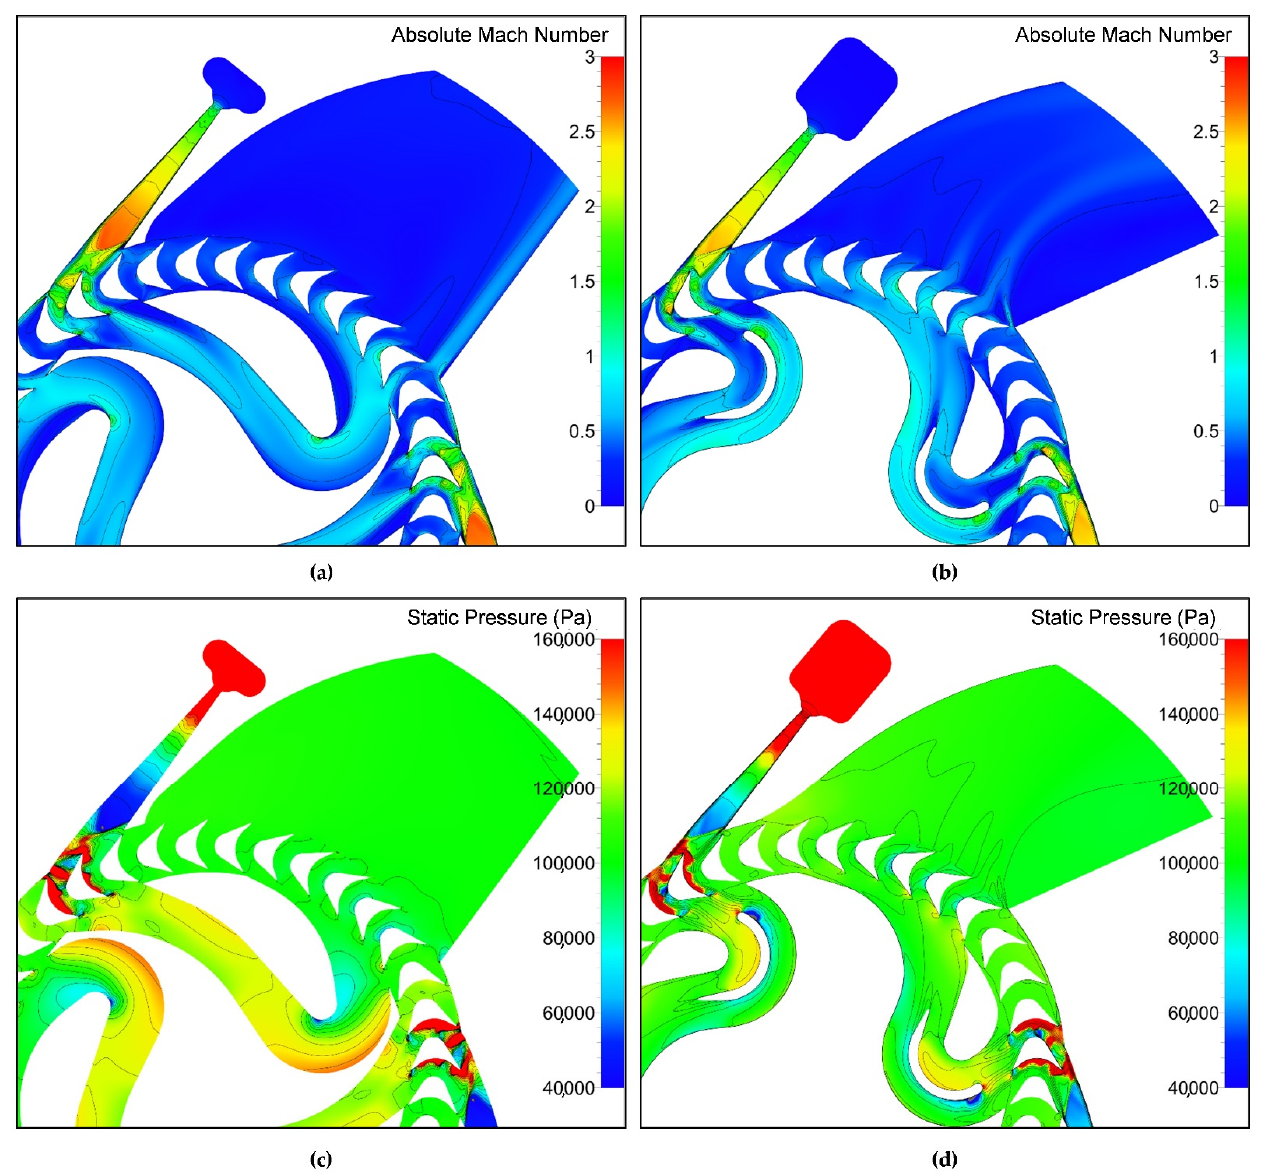
Figure 13. Comparison of CFD simulations results at 50% span: ( a ) Absolute Mach Number plot of Version 2a ; ( b ) Absolute Mach Number plot of Version 3 ; ( c ) Static Pressure plot of Version 2a ; ( d ) Static Pressure plot of Version 3 .